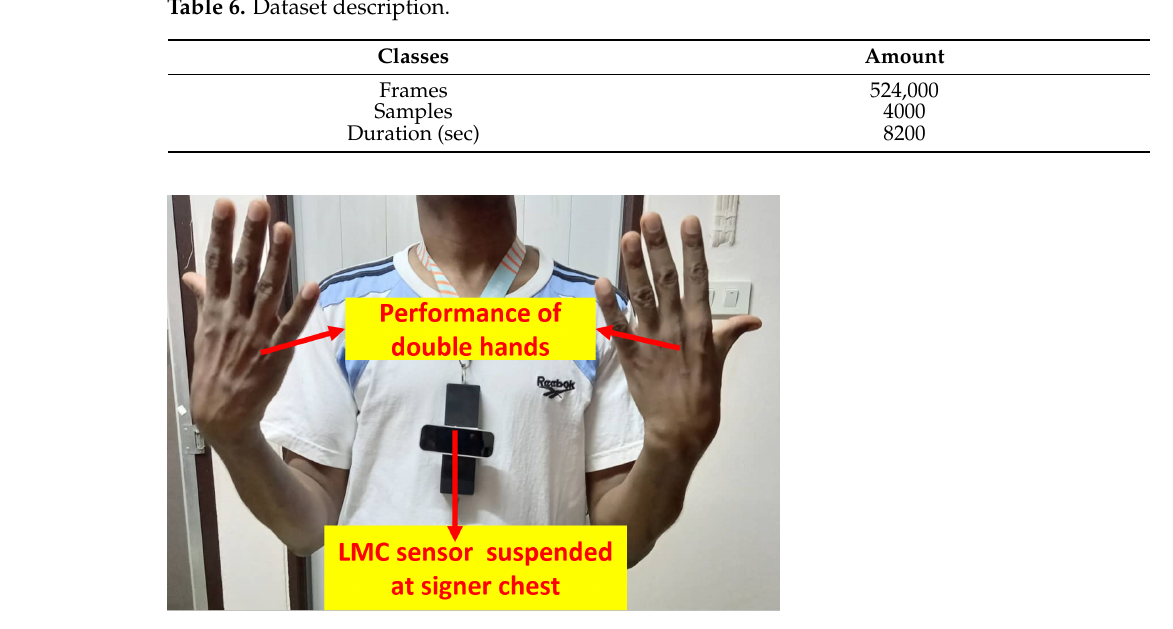
Figure 7. Experimental set up.